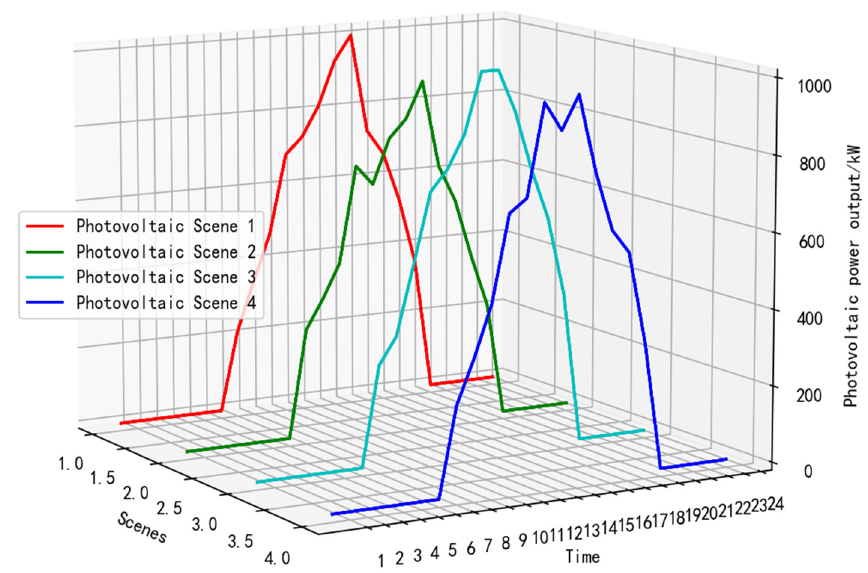
Figure 4. Four photovoltaic classic scene curves.